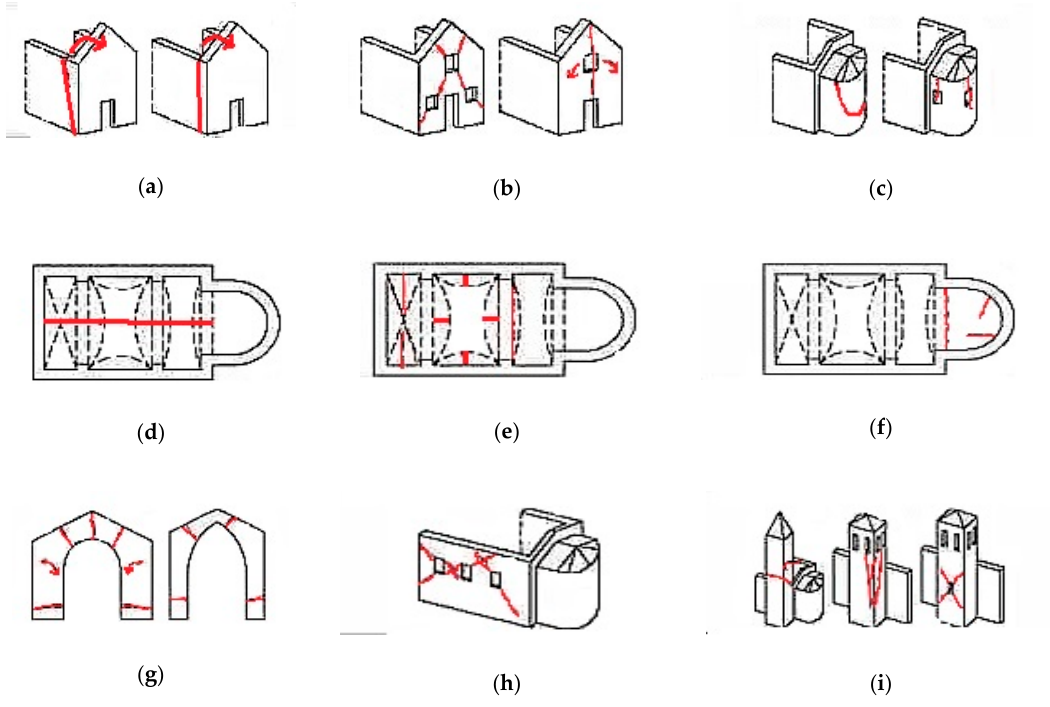
Figure 1. Failure mechanisms in Romanesque churches: ( a ) overturning of the facade; ( b ) shear mechanisms in the facade; ( c ) overturning of the apse; ( d ) transversal vibration of the nave; ( e ) vaults of the nave; ( f ) vaults in the presbytery or the apse; ( g ) triumphal arch; ( h ) shear failure of the walls; ( i ) bell